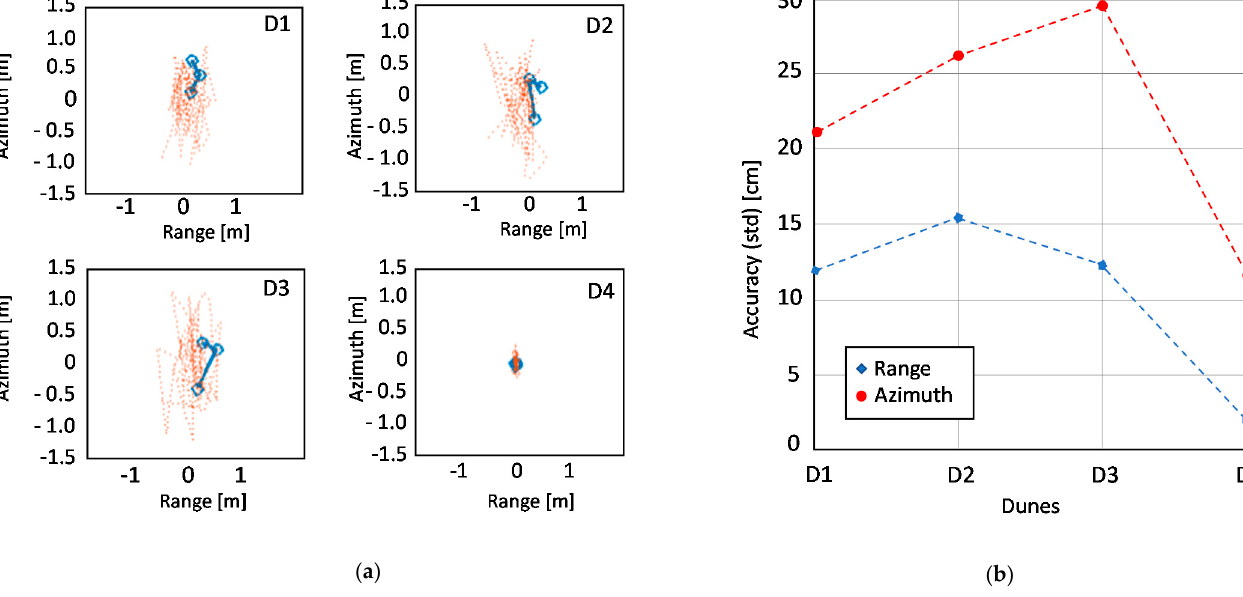
Figure 14. Average 2D ground track of the dunes across the whole considered period estimated by SAR offset tracking ( a ); accuracy of measured displacements in range and azimuth for each dune ( b ).